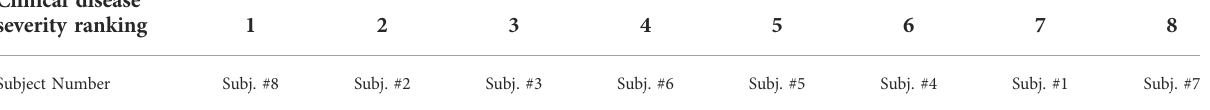
TABLE 4 Strati fi cation of patients from lowest (value of 1) to highest (value of 8) disease severity. Clinical disease severity ranking